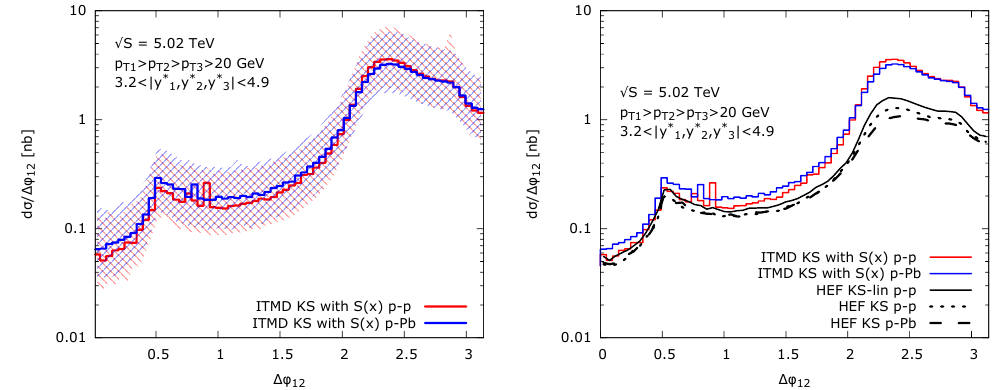
Figure 4 . Di(cid:11)erential cross sections in the azimuthal angle between the two hardest jets (cid:1) (cid:30) 12 for p-p and p-Pb collisions. Left plot represents calculation with uncertainty due to scale variation. Right plot shows the comparison of the ITMD and HEF for central values.